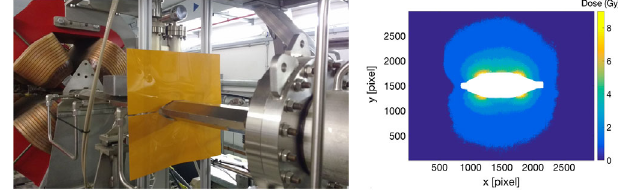
FIG. 5. The radiochromic film installed in the storage ring of DLS (left) and the calculated dose